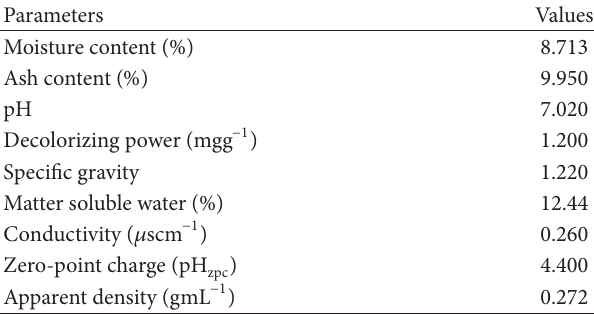
T 1: Physicochemical characteristics of